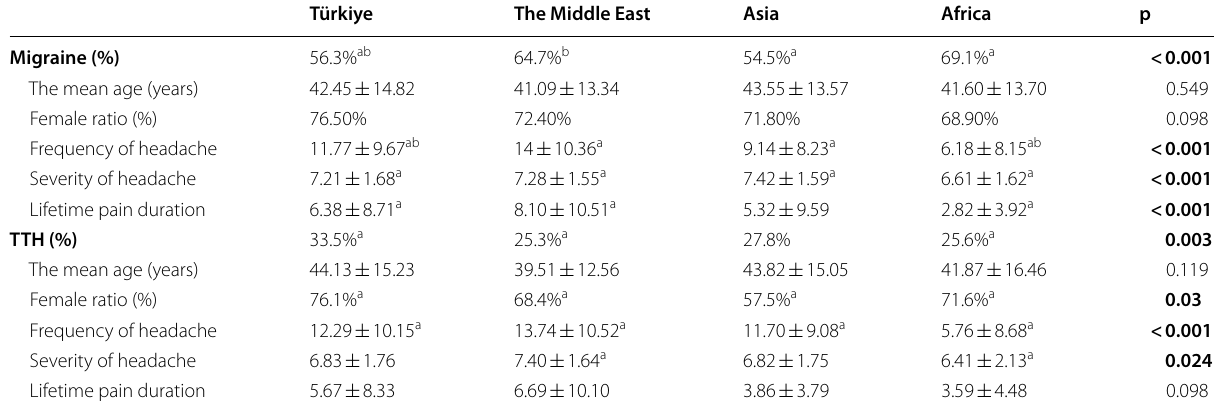
Each subscript letter denotes a subset of categories whose column proportions/means do differ significantly from each other at the 0.05